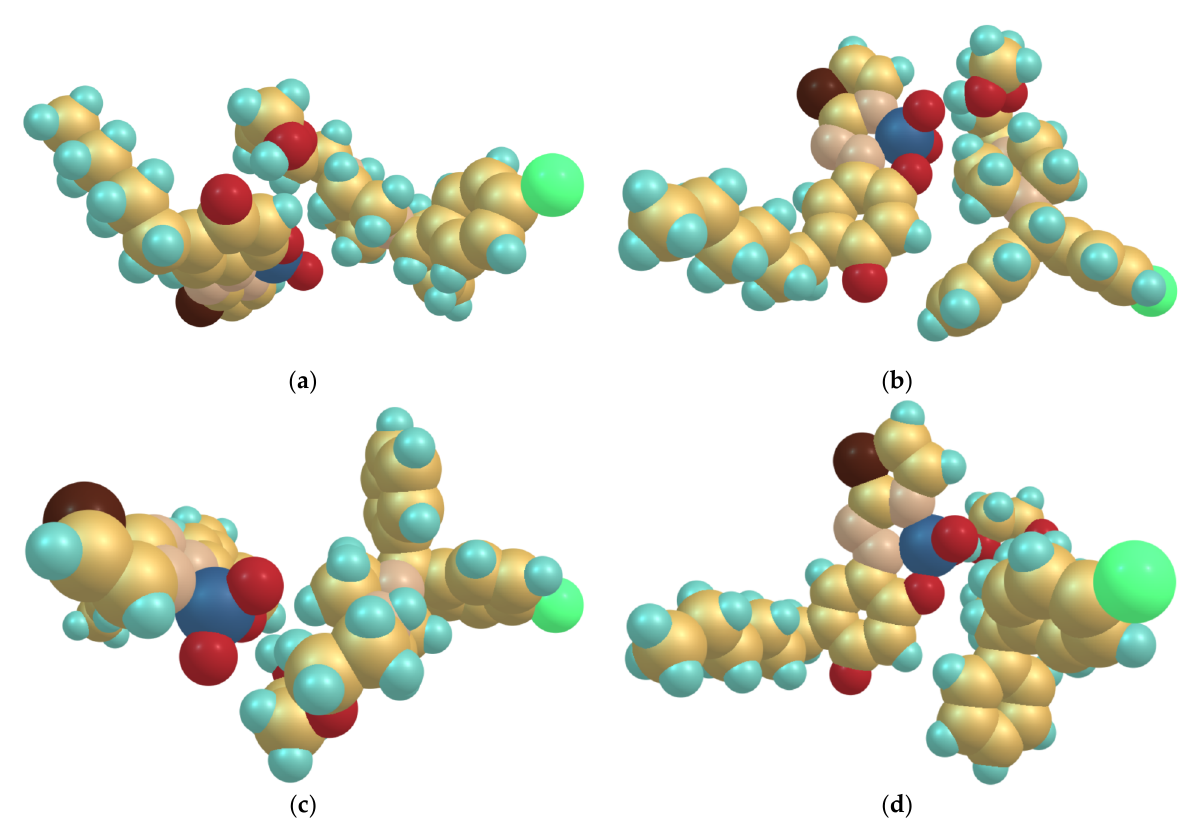
Figure 9. Optimized ground-state structures of the ion-association complex at the HF/6-31G level